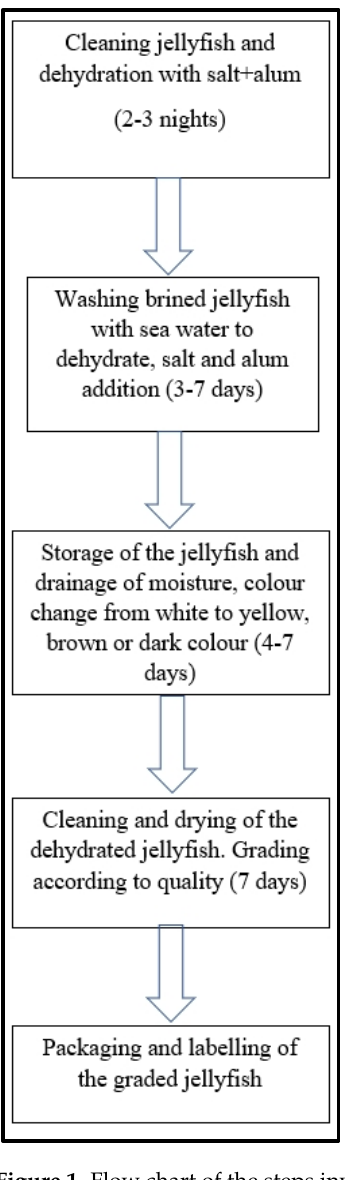
Figure 1. Flow chart of the steps involved in traditional jellyfish processing.